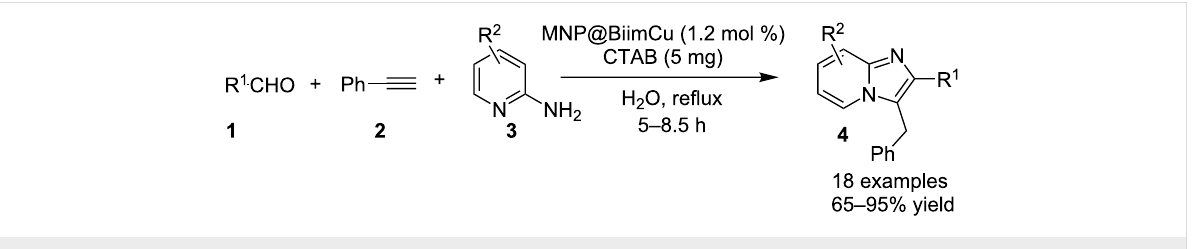
Scheme 9: Heterogeneous synthesis of